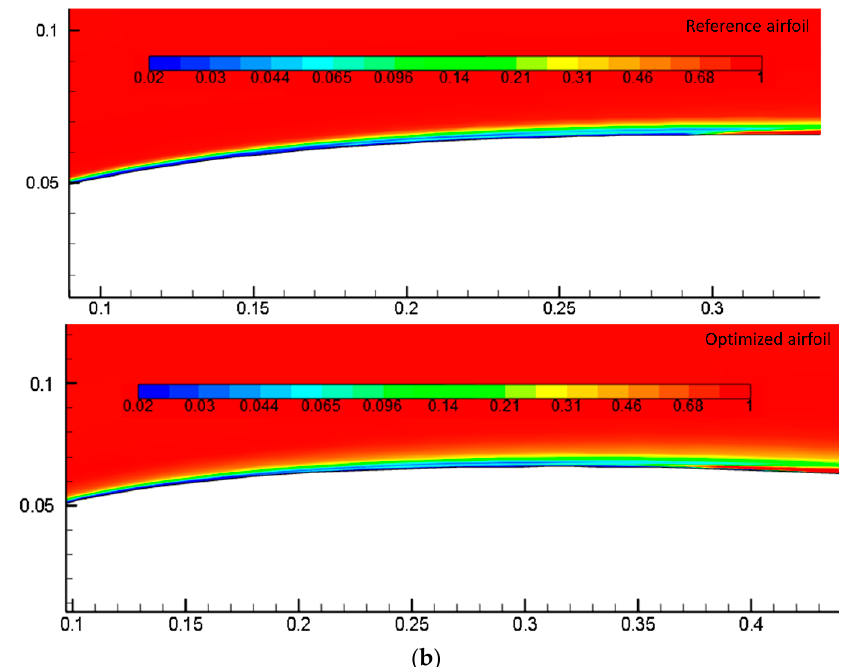
Figure 18. Assessment of the ( a ) velocity contours for the reference and optimized airfoil, and ( b ) intermittency contours the reference and optimized airfoil for endurance maximization.